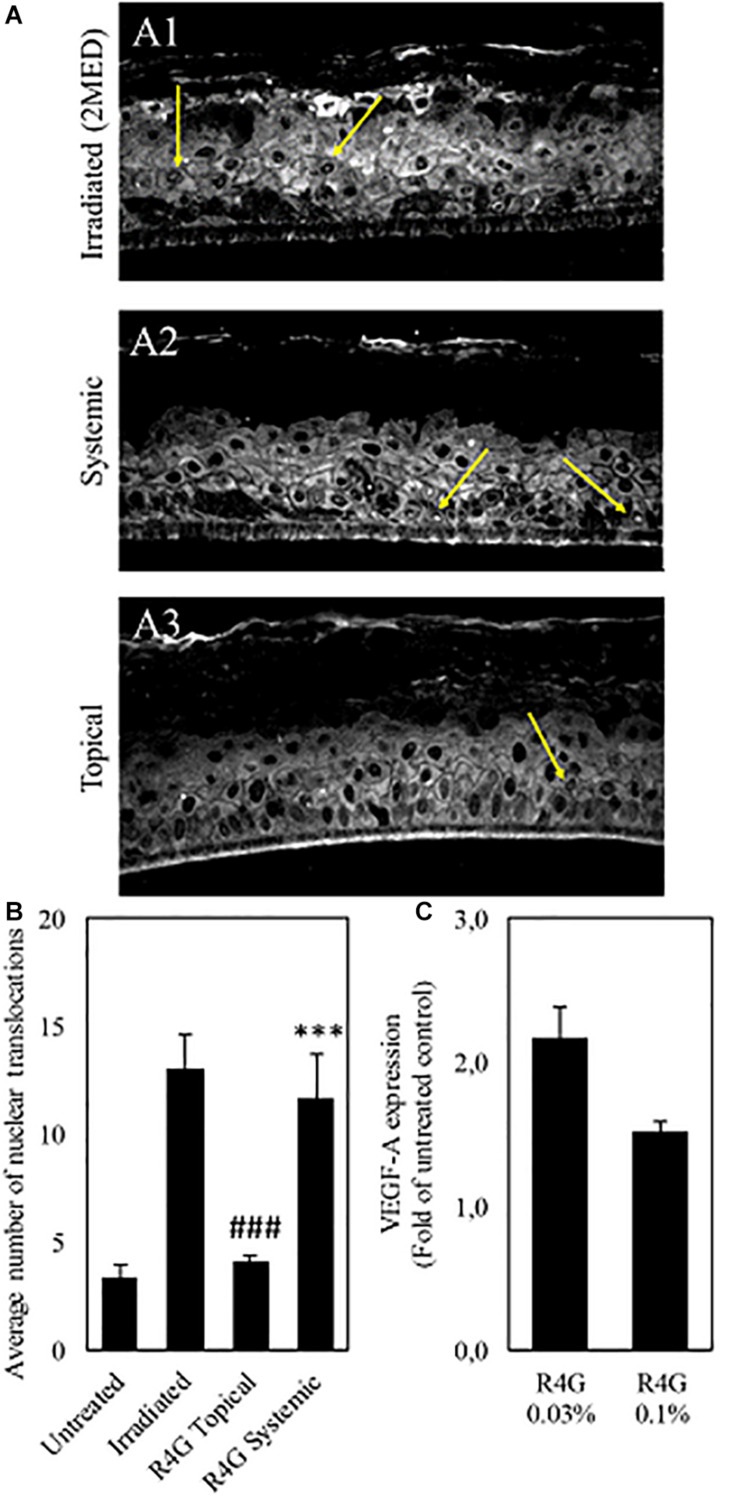
(A) Immunostaining against NF-κB (yellow arrows) on irradiated RHE (A1), on RHE after systemic (A2) and topical (A3) treatment with R4G extract. (B) Quantification of NF-κB nuclear translocation signal. The signal is significantly higher on irradiated control compared to untreated RHE. Topical exposure with R4G extract has significantly reduced NF-kB translocation compared to irradiated while systemic treatment has no significant effect vs. the irradiated control. (C) Modulation of VEGF-A gene expression after 72 h treatment relative to untreated control. Data are means ± standard errors (n ≥ 3; ###p < 0.001 vs. irradiation, ***p < 0.001 vs. untreated, based on Student’s t-test). MED, minimal erythema dose.